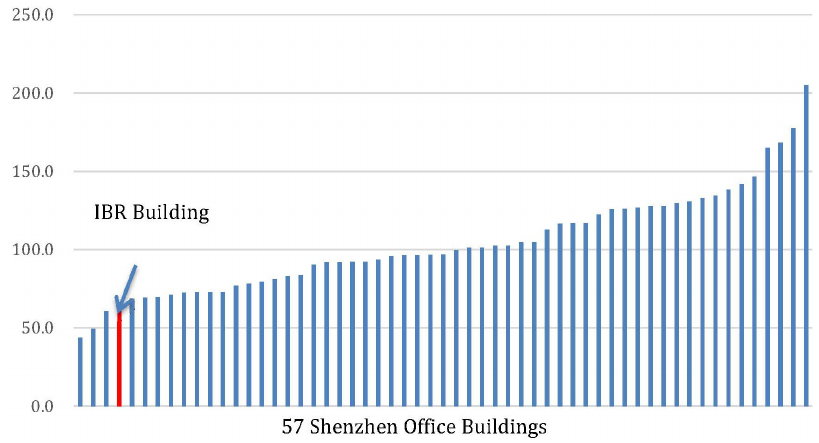
Figure 10. Energy Use Intensity (EUI) for 57 Shenzhen office